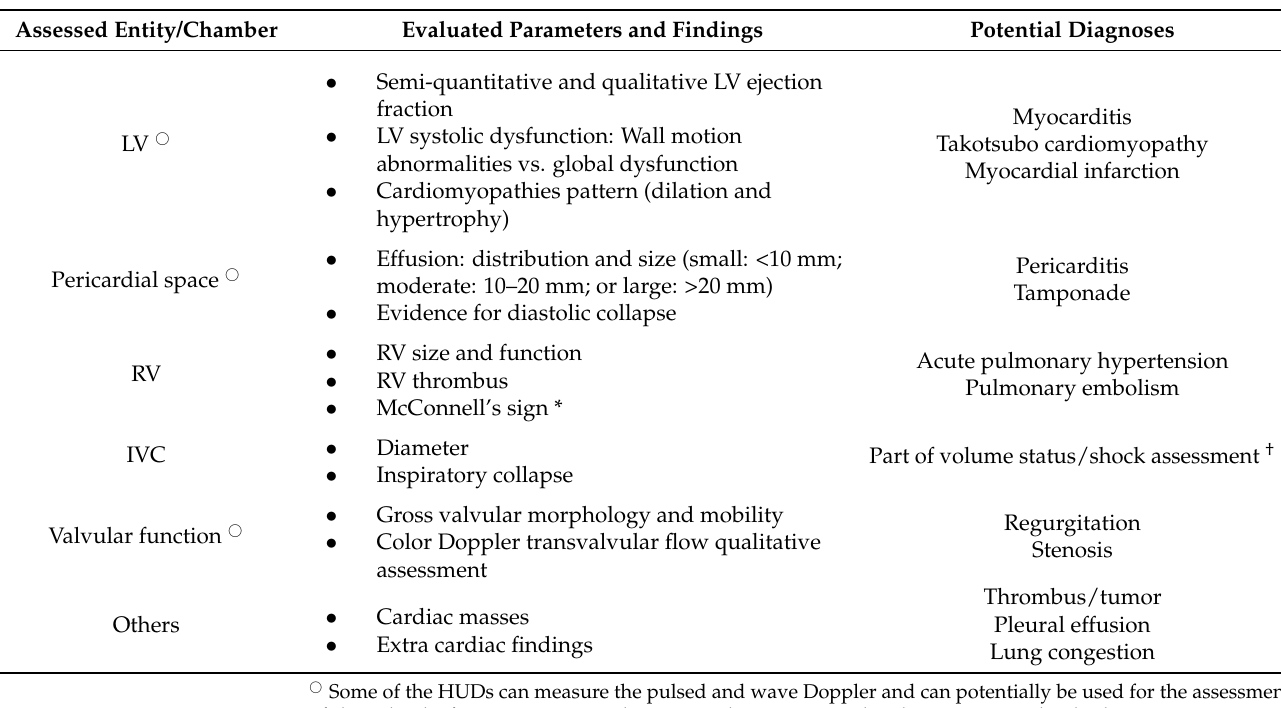
Table 3. Characteristics of echocardiographic findings using HUD in different COVID-19 clinical settings of myocardial